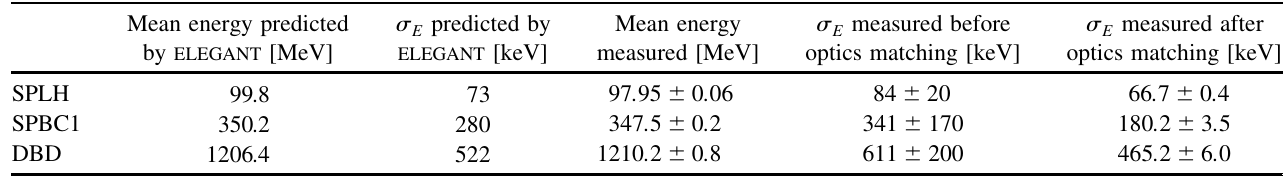
TABLE III. Mean energy and rms energy spread, simulated and measured at three FERMI spectrometer lines, respectively before and after the ELEGANT -based optics control.